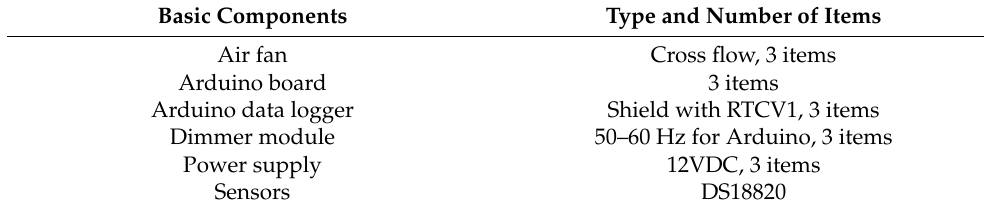
Table 3. Technical characteristics of ventilation